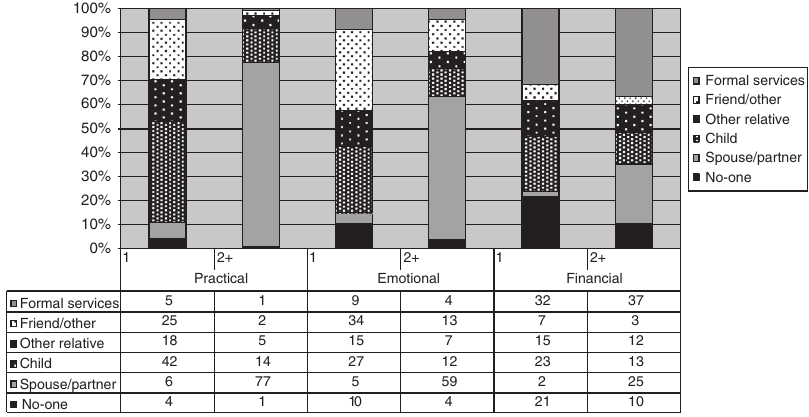
Figure 7. Bar chart showing who the respondent would turn to first for support, by household type (li v ing alone/2 (cid:3)